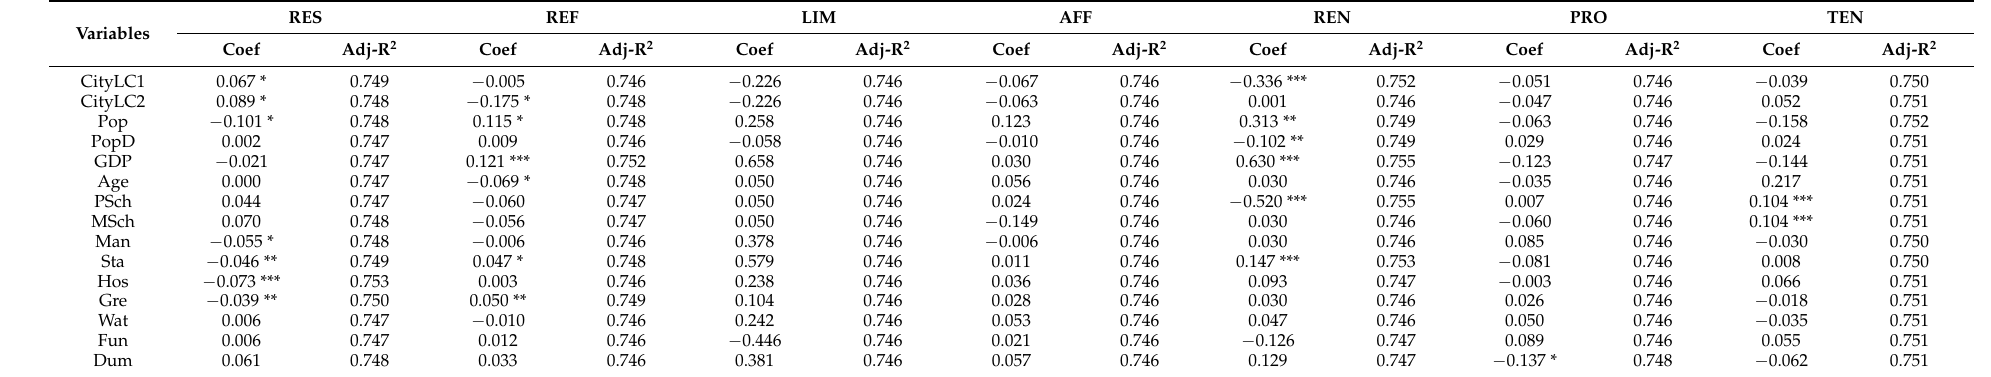
Table 6. Interactive regression results of the NPCOM (N =